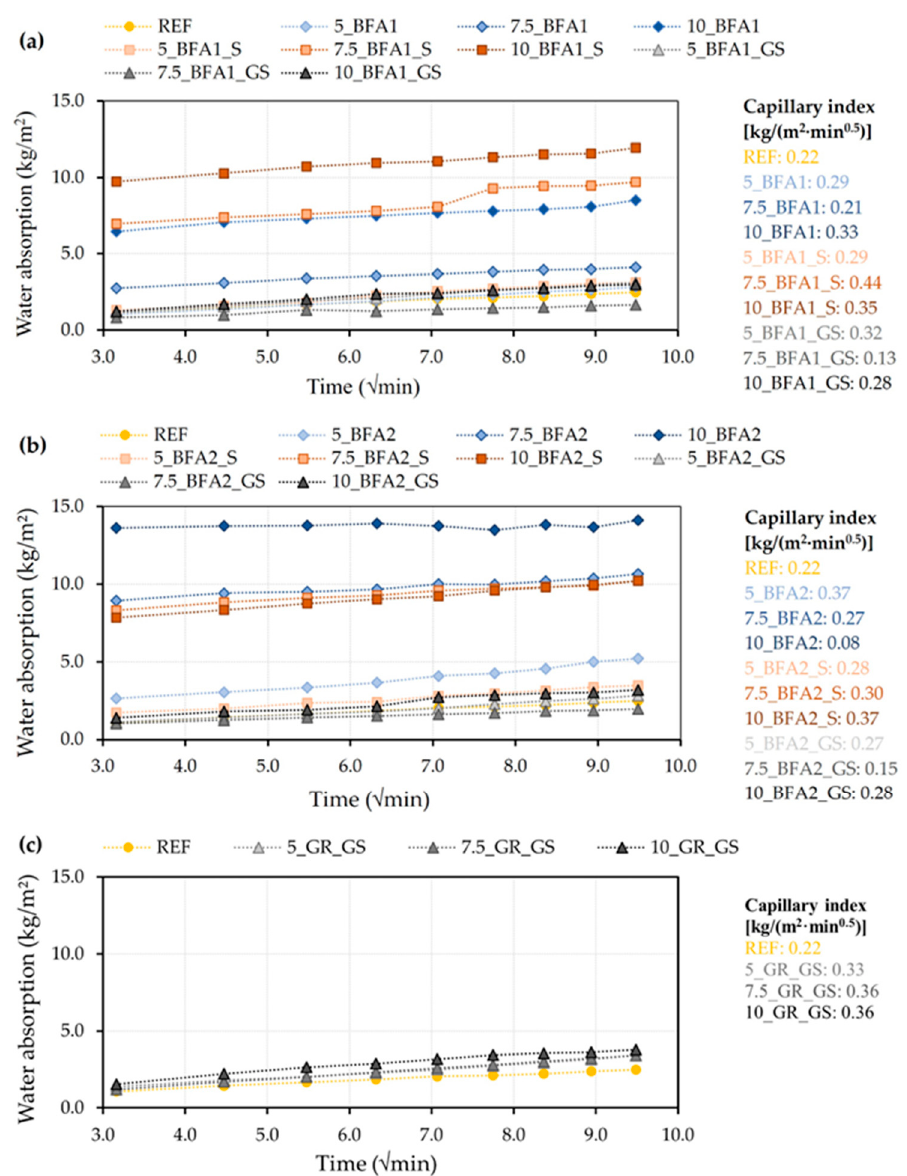
Figure 6. Water absorption by capillary of mortars cured for 28 days. Samples prepared with: ( a ) BFA1, ( b ) BFA2, and ( c ) SG.